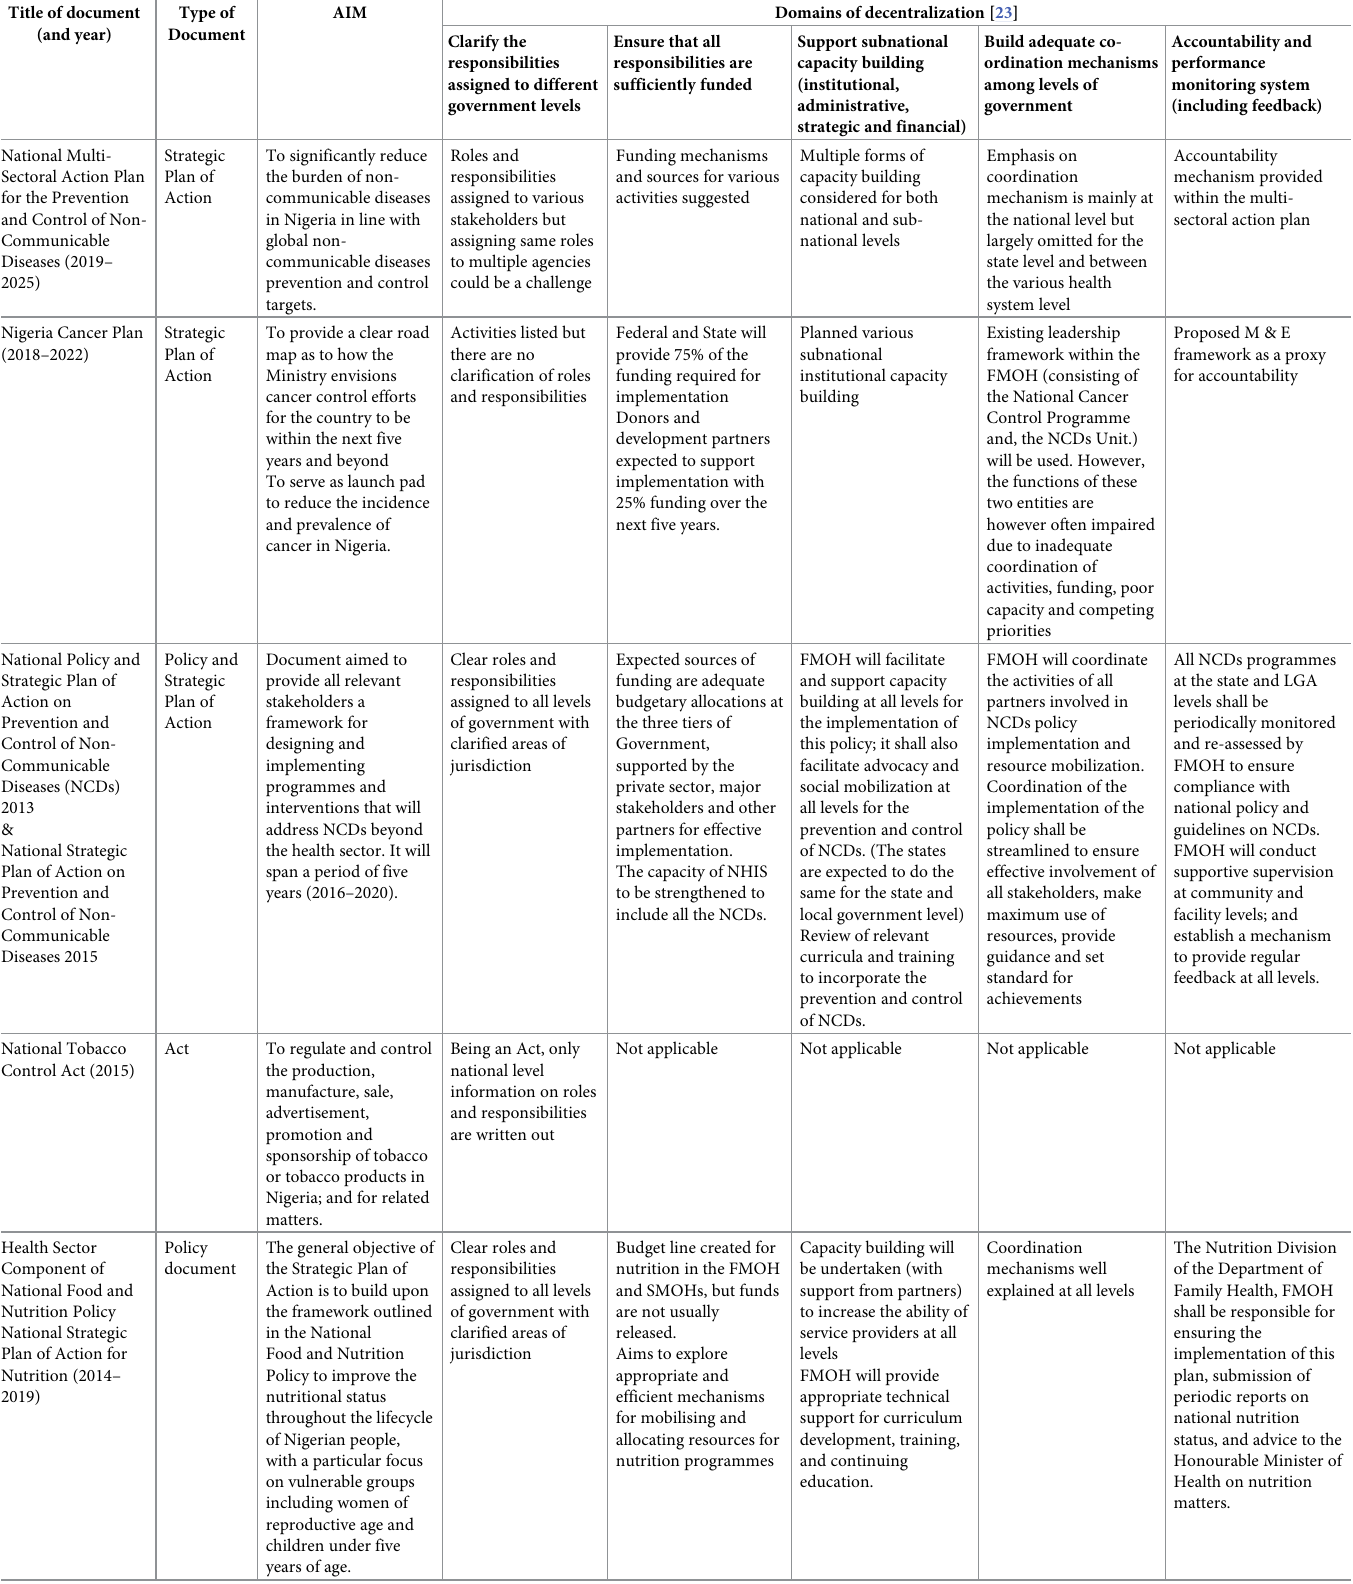
Table 2. Summary of NCDs strategy and policy documents reviewed and their alignment with the concept of